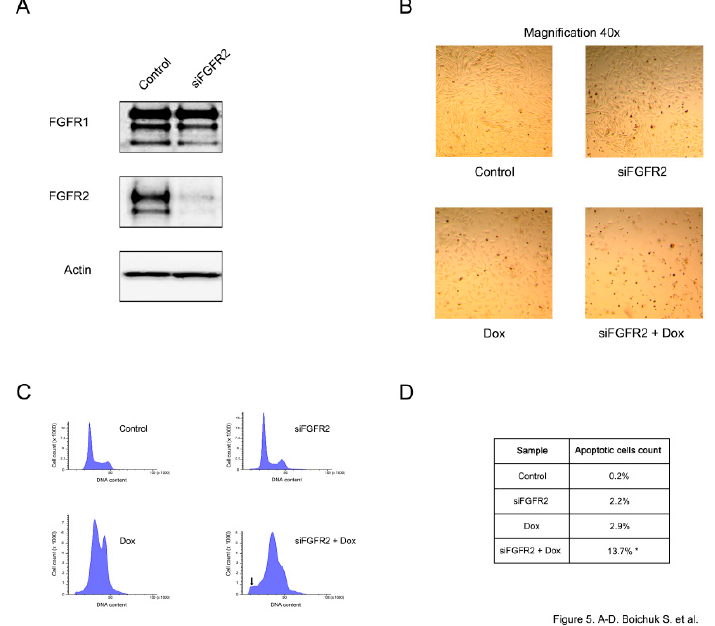
Figure 5. FGFR2 knockdown sensitizes GISTs to topoisomerase II inhibitors and induces their apoptosis. ( A ) GIST T-1R cells were transfected with scrambled siRNA (control) or siRNA targeting FGFR2 for 48 h. The expression of FGFR-1,2 was analyzed by western blotting. Actin was used as a loading control. ( B ) The light microscopy images of doxorubicin (Dox)-treated GIST cells (0.5 µ g / mL for 48 h) previously transfected with scrambled siRNA (control) or siFGFR2 for 48 h. ( C ) Representative flow cytometry histograms showing the cell-cycle distribution of GIST T-1R cells transfected with control siRNA or siRNA FGFR2 for 48 h and treated with DMSO or Dox (0.5 µ g / mL) for another 48 h. Experiments were conducted in quadruplicate and at least 150,000 cells were counted per experiment. The increase of apoptotic cells was evidenced by a sub-G1 peak in cells depleted of FGFR2 and treated with Dox (noted by arrow). ( D ) Quantification of apoptotic cells was measured by flow cytometry, * p < 0.05.